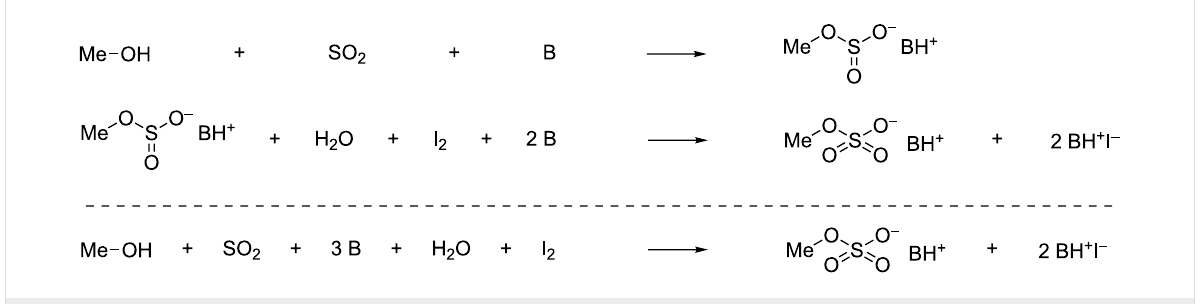
Figure 3: The equation of the KF chemical reaction.